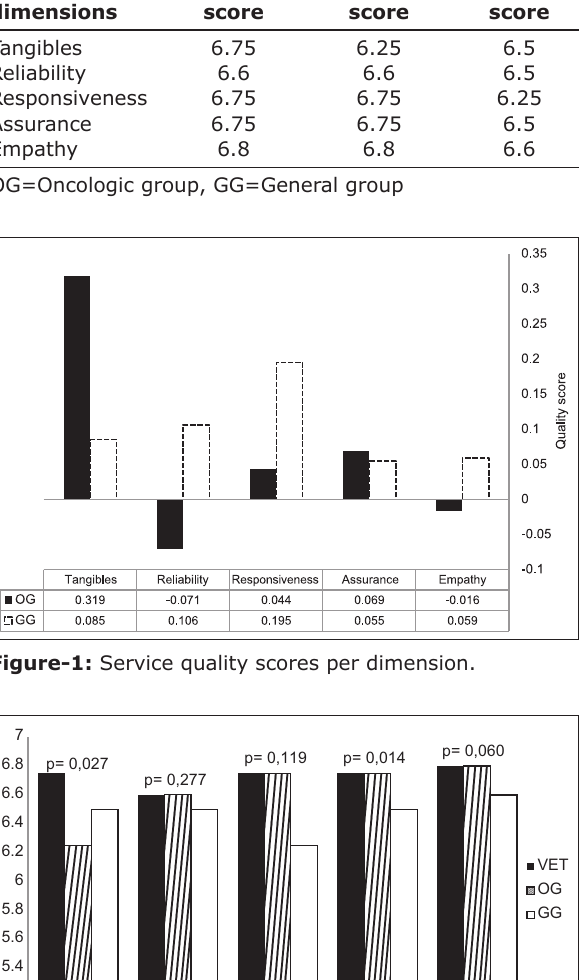
Table-3: Summarized information regarding median expectations scores per dimension for all sample groups. Service dimensions